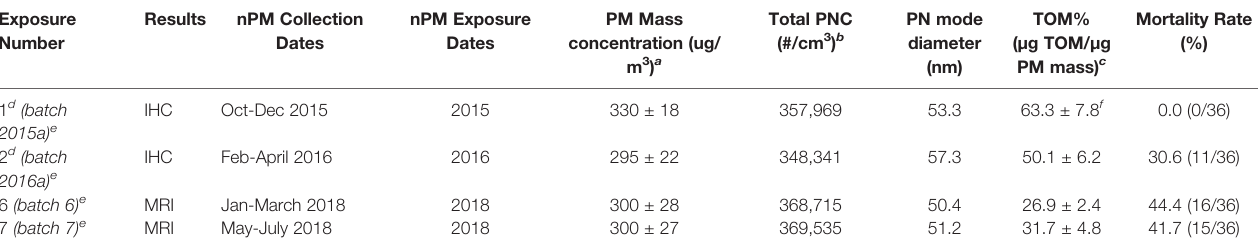
Table adapted from Liu et al. These batches of nPM have been reported from prior experiments (16). PNC, particle number concentration; TOM, total organic matter; PM, particulate matter; IHC, immunohistochemistry; MRI, magnetic resonance imaging. a Average PM values are the average DustTrack observations in the mid-way of each day of exposure. The variation (SD) through different days are less than 10% of the average values. b SMPS records total PNC values for each nPM batch used in the beginning of each exposure. c Total mass of Organic matter (OM) is reported by multiplying total organic carbon (TOC)% by a factor of 1.6 ± 0.2 recommended for urban aerosols to account for contributions of non- carbon atoms and the effect of PM oxygenation in the ambient through photochemistry (17). d There were no exposure differences between Exposures 1 and 2. e nPM exposure batch numbers represent those listed in Zhang et al. (18). f Data variation is represented as standard deviation